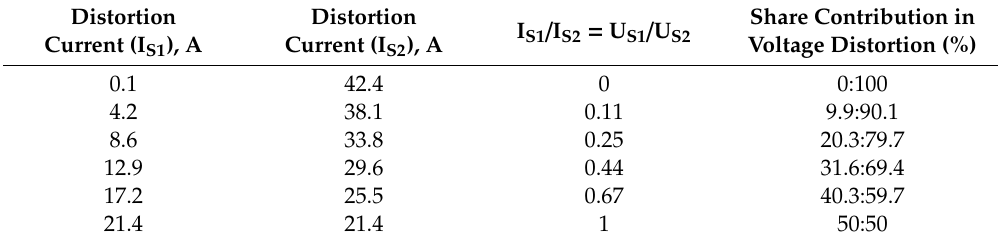
Table 2. The values of calculated currents and nonlinear load